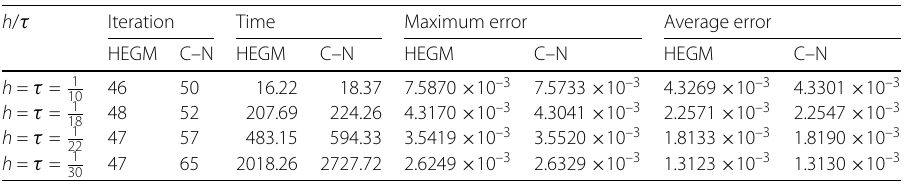
Table 2 Comparison between Crank–Nicolson (C–N) high-order finite difference method and HEGM for Example 2 when γ =